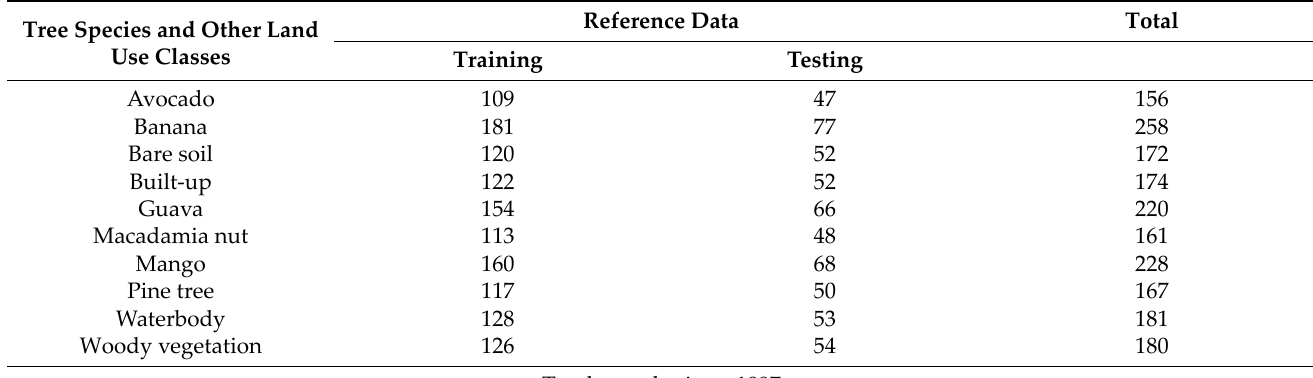
Table 1. Number of samples for fruit‑tree crops and other existing land uses, the structure of training and testing data for each class used to map fruit‑tree crops in Levubu subtropical